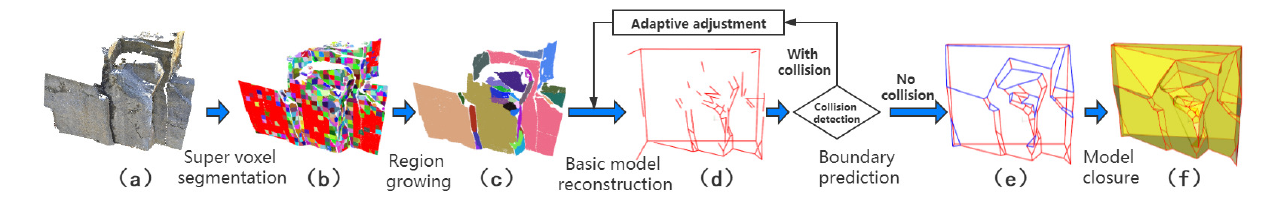
Figure 1. Algorithm flowchart. ( a ) Input point cloud. ( b ) Surface over-segmentation result. ( c ) Seg- mentation result. ( d ) Basic model. ( e ) Plane closure. ( f ) Reconstruction